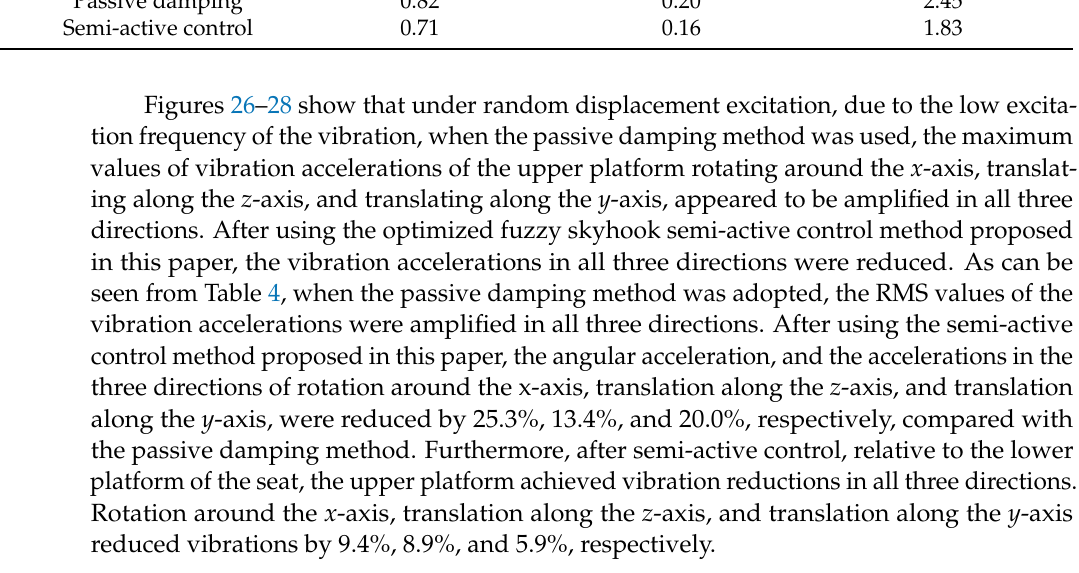
Table 4. Simulation results (RMS value) of the multi-DOF damping seat platform.